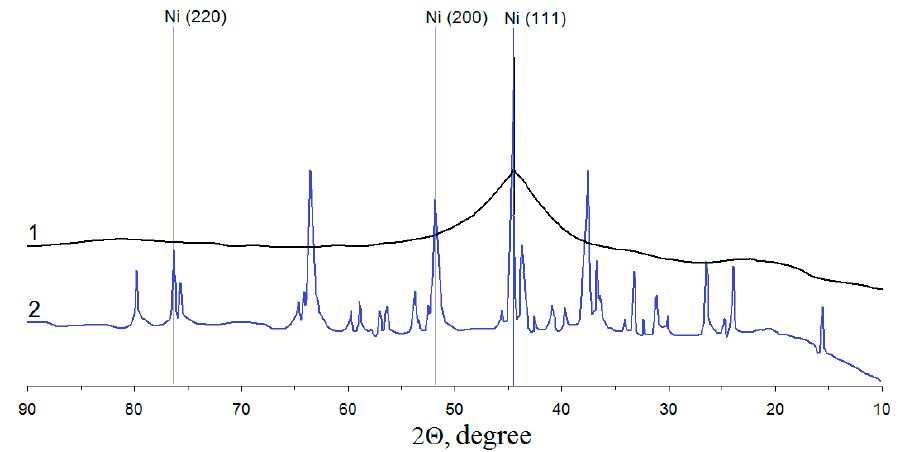
Figure 7. X-ray di ff ractometry (XRD) patterns of Ni / р HEMA-gr-PVP composites before thermal Figure 7. X-ray diffractometry (XRD) patterns of Ni/ р HEMA-gr-PVP composites before thermal treatment ( 1 ) and after thermal treatment ( 2 treatment ( 1 ) and after thermal treatment ( 2 ).